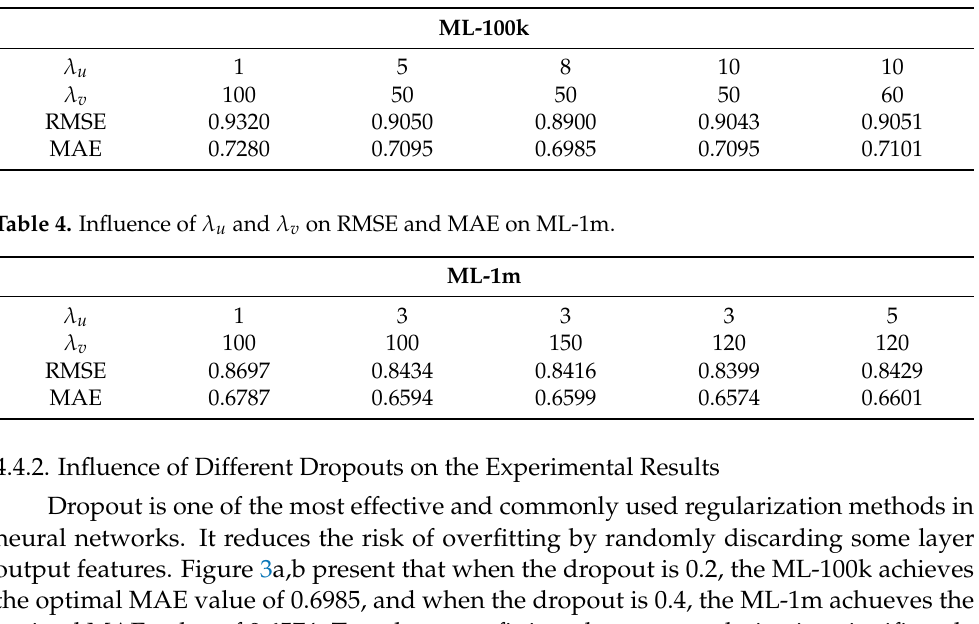
Table 3. Influence of λ u and λ v on RMSE and MAE on ML-100k.